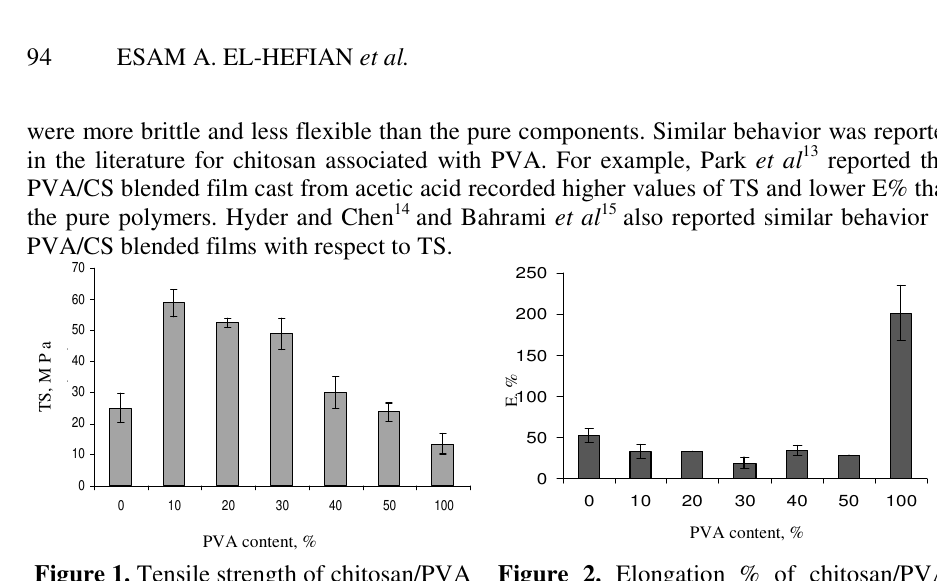
Figure 2. Elongation % of chitosan/PVA blended films